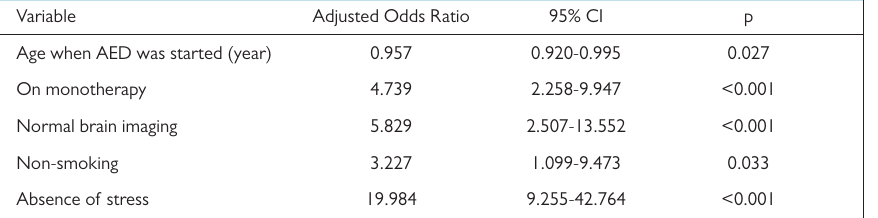
Table 3. Multivariate analysis of predicting factors for good seizure control